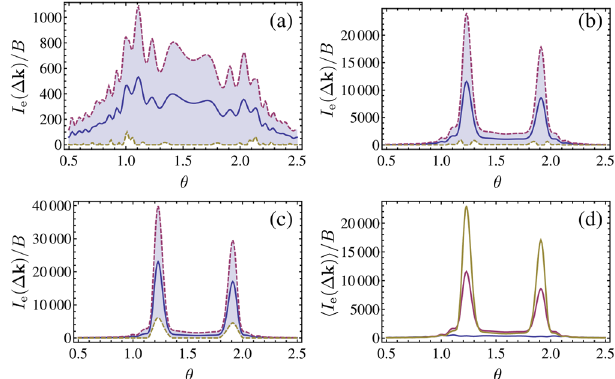
FIG. 10. Angular distribution of the elastic component of the scattered light intensity in the presence of short-range order [Eq. (107)] along the ϕ ¼ π = 4 direction. The lattice depth is ≈ 0 . 3 . We only taken to be s ¼ 25 , κ ¼ 1 . 5 [Eq. (59)], and m RPA show the magnetic Bragg peaks for the case where only the down species is imaged. In (a) – (c), the solid lines represent the ensemble averages of the intensity over 100 stochastic realiza- tions at different temperatures: (a) K ¼ − 0 . 3 , (b) K ¼ − 0 . 42 , and (c) K ¼ − 0 . 43 . The corresponding fluctuations (sample standard deviation) are given by the dashed lines. The different average intensities of (a) – (c) are shown together in (d). Typical individual lattice configurations are shown in Fig.